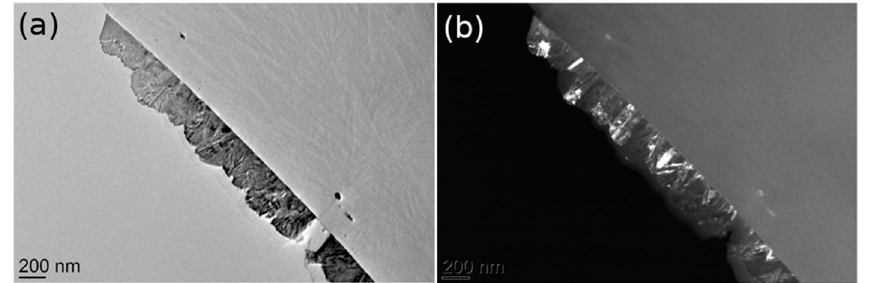
Figure 2. TEM cross-section images of a CVD film. ( a ) bright-field image and ( b ) the corresponding dark-field image.